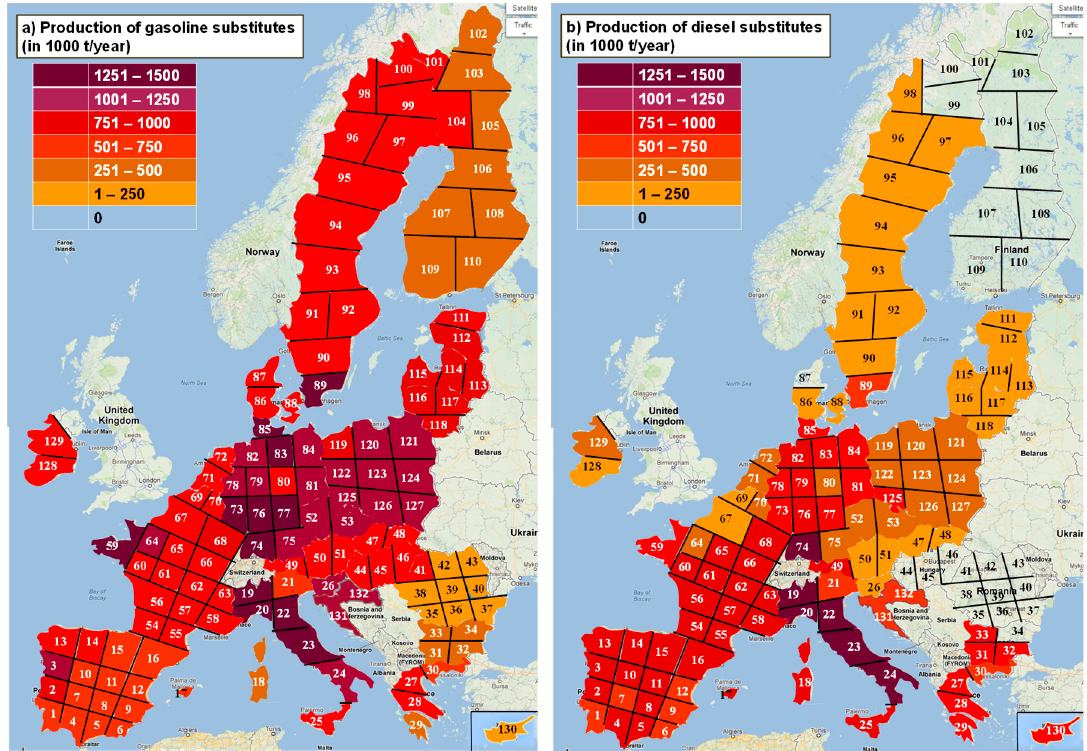
Figure 8. Production of ( a ) gasoline and ( b ) diesel substitutes for Scenario 3 (the highest possible production of biofuels) when maximizing sustainability profit.